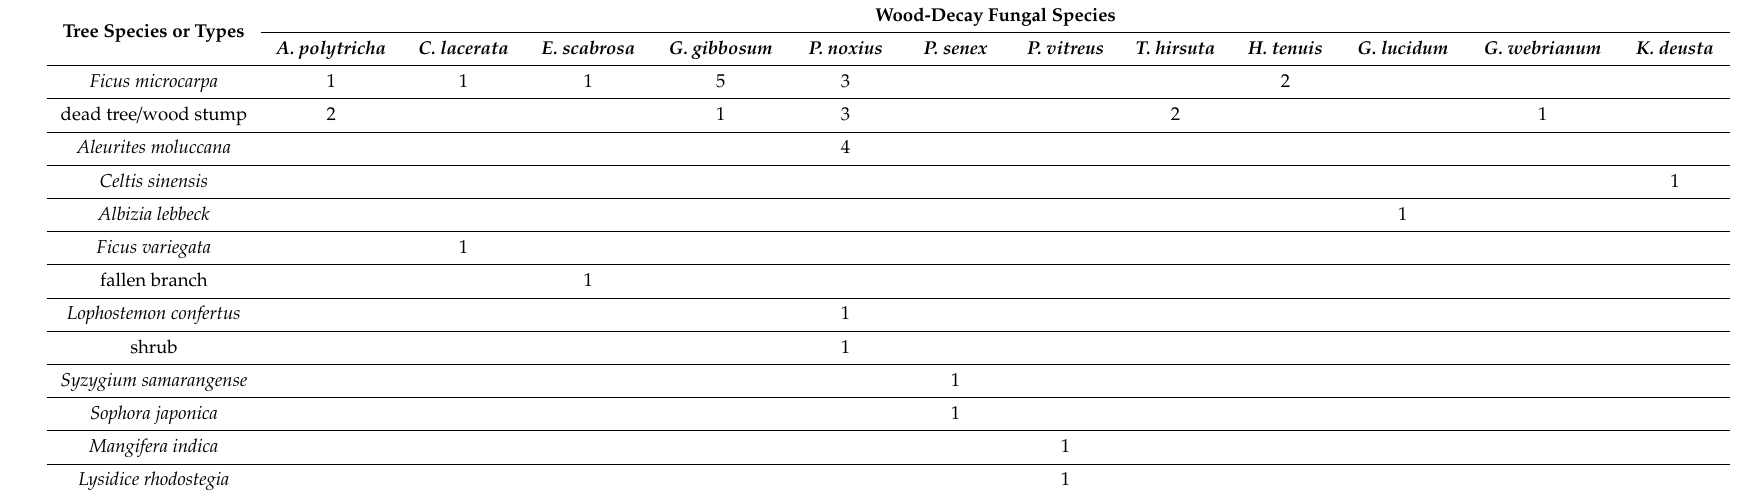
Table 3. A list of number of trees from each species (or wood types) that were infected by di ff erent wood-decay fungi. Tree Species or